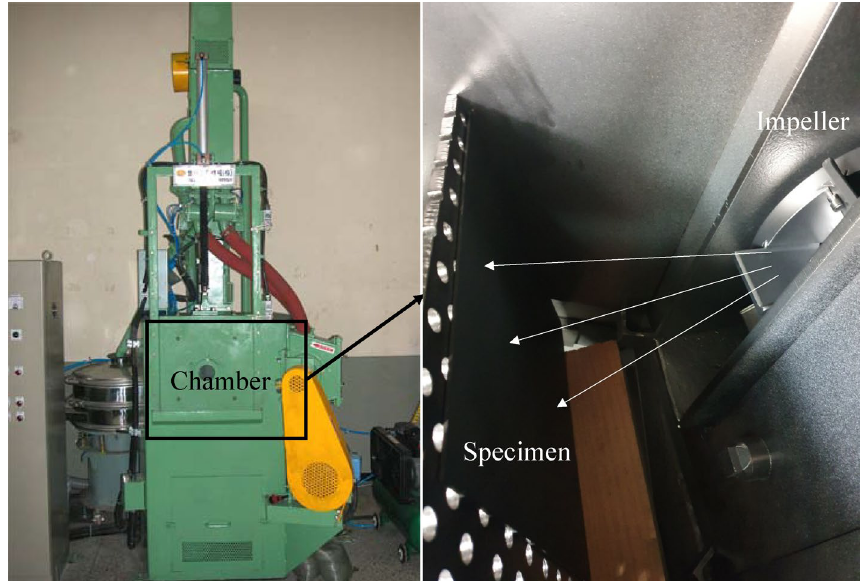
Figure 6. Impeller-typed shot blaster and specimens 23 .